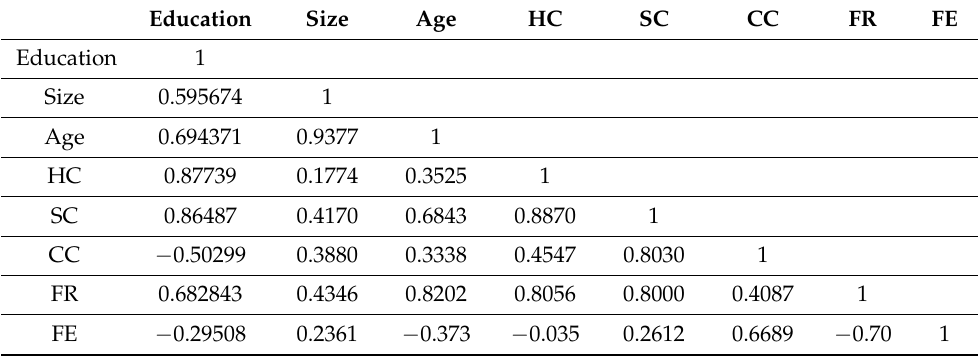
Table 4. Values of the correlation between the